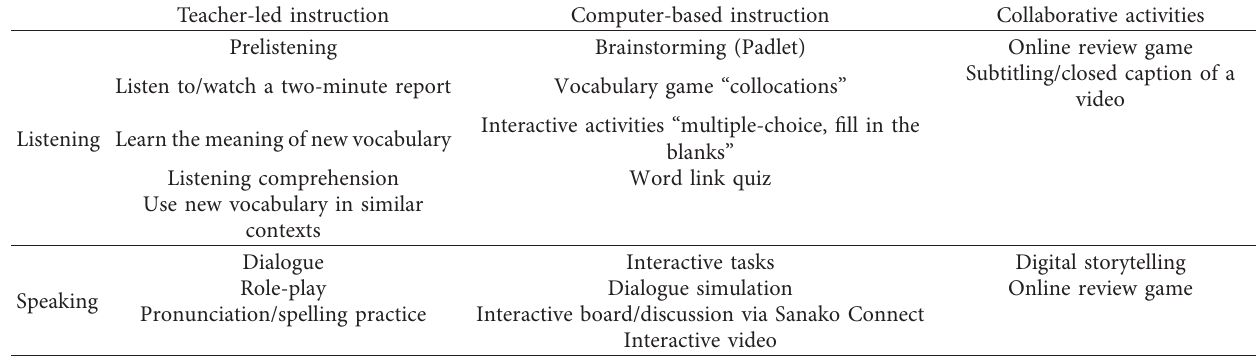
Figure 8: Description of the blended learning Table 2: Application of the model in a speaking and listening unit.